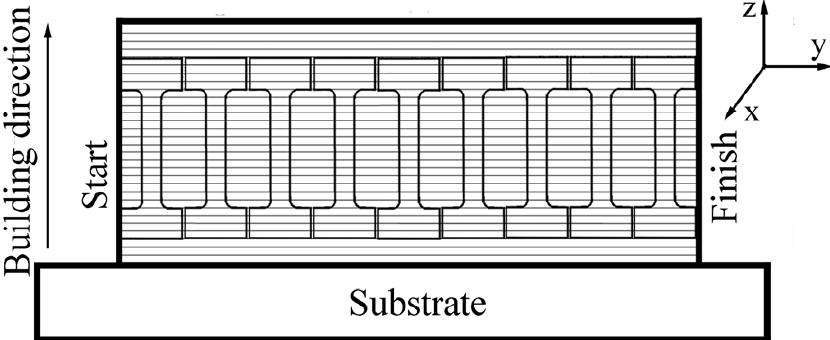
Figure 1. A scheme of specimen orientation relative to the building direction of the